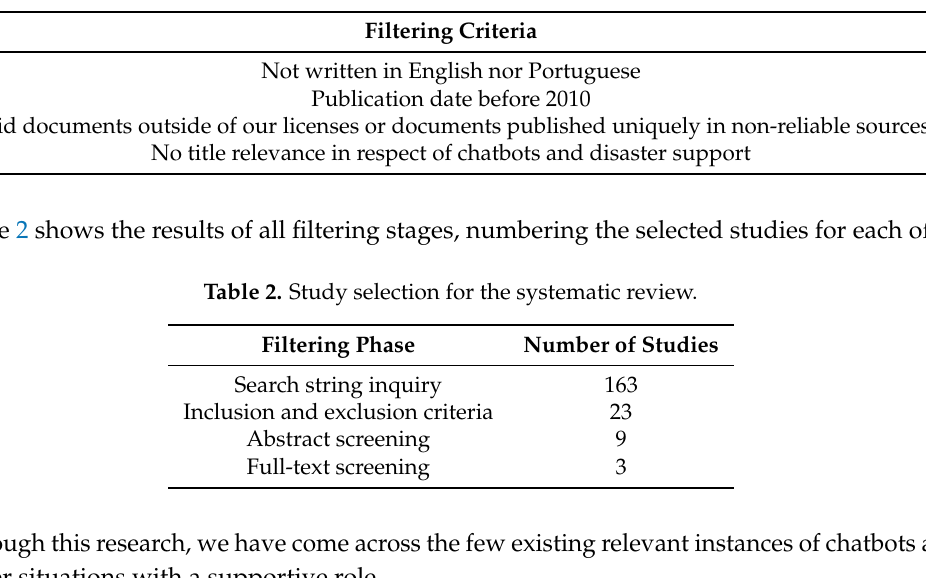
Table 1. Filtering criteria for the systematic review.